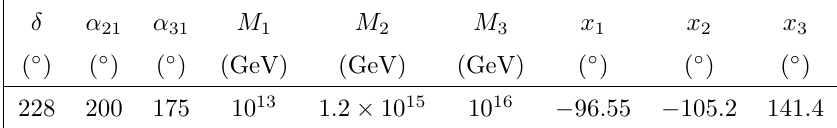
Table 5 . The benchmark values for high-scale leptogenesis with normal ordering. Here we